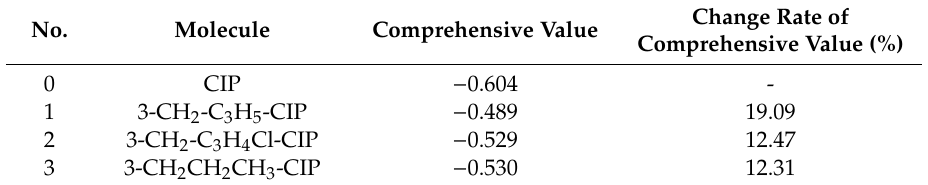
Table 4. Prediction of double-activity characterization values of the CIP derivatives’ green algae and bacterial genotoxicity.